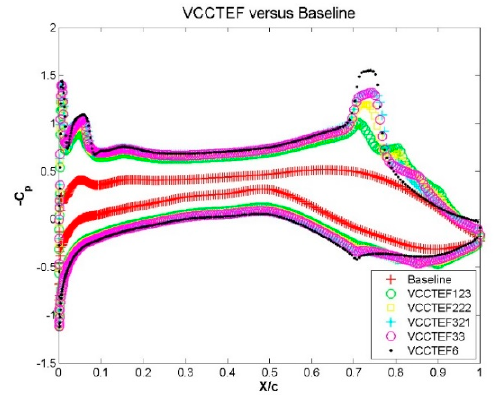
Figure 21. Comparison of computed baseline airfoil coefficient of pressure with VCCTEF configurations at a zero angle of attack.